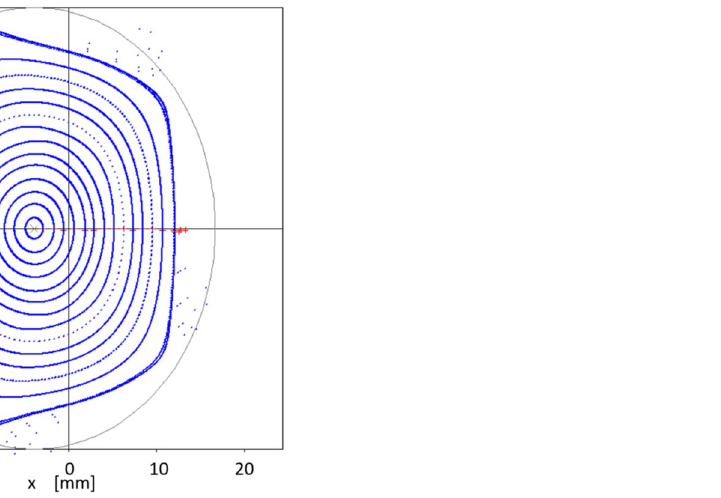
Figure 13. Structure of phase space ( x , p x ) for δ = − 2% when various initial conditions are used for particle tracking simulation in OPA, using the set of sextupoles { S 2 }